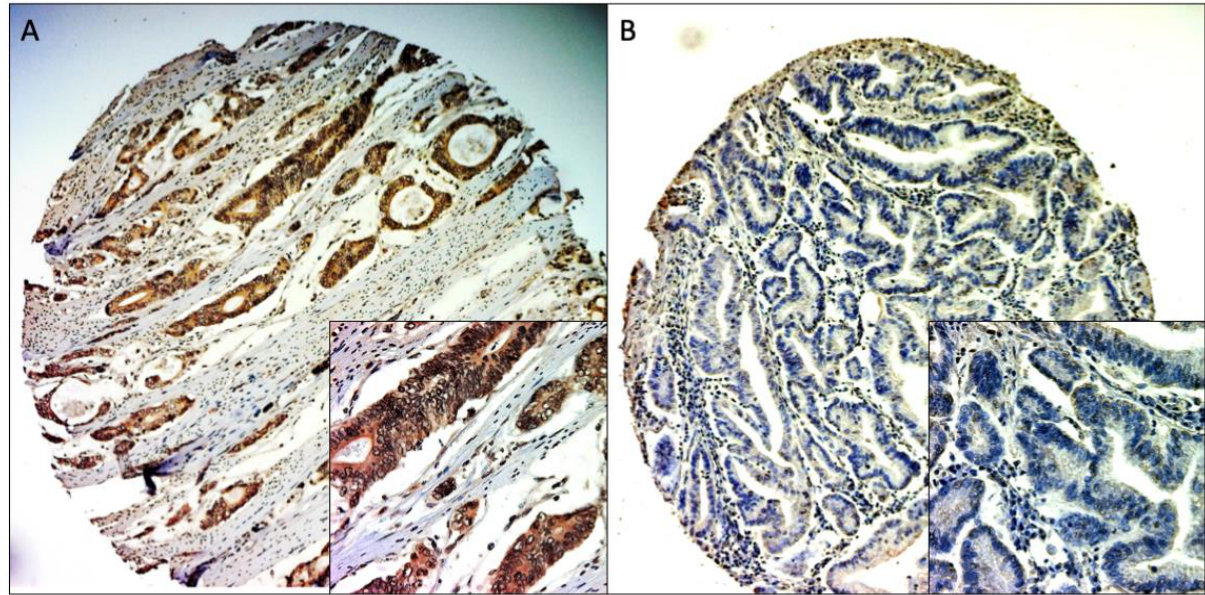
Figure 1. Representative MACC1 IHC staining of TMA cores. ( A ) positive staining (100× and 400× magnitude), ( B ) negative staining (100× and 400× magnitude).